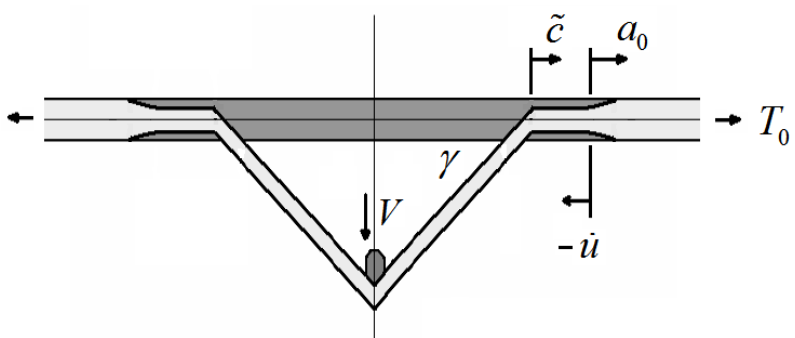
Figure 1. Classic diagram of a projectile impacting a 1D string. (Based on a diagram in Rakhmatulin and Dem’yanov [15] but revised and re-drawn with our notation.)